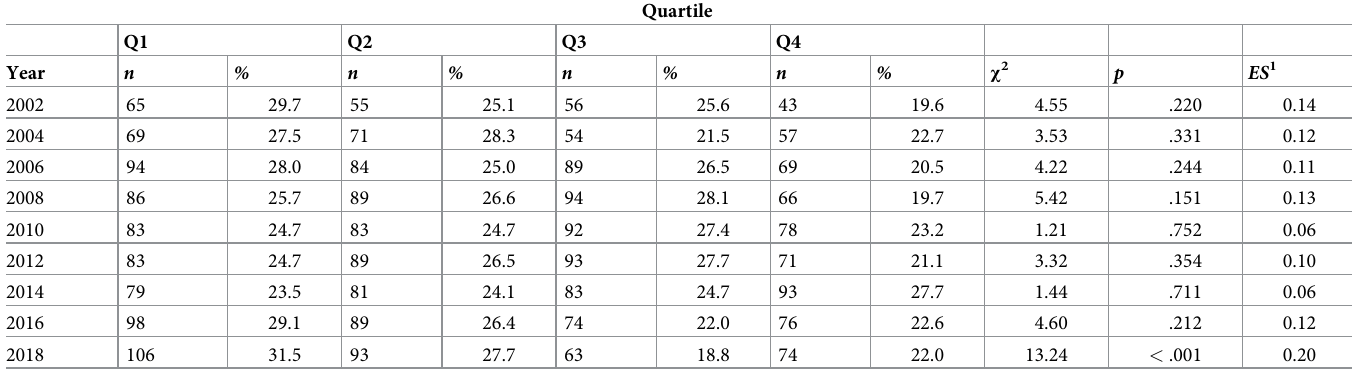
Table 5. Distribution of birth dates in female soccer players participating in the under-20 world cup 2002–2018.